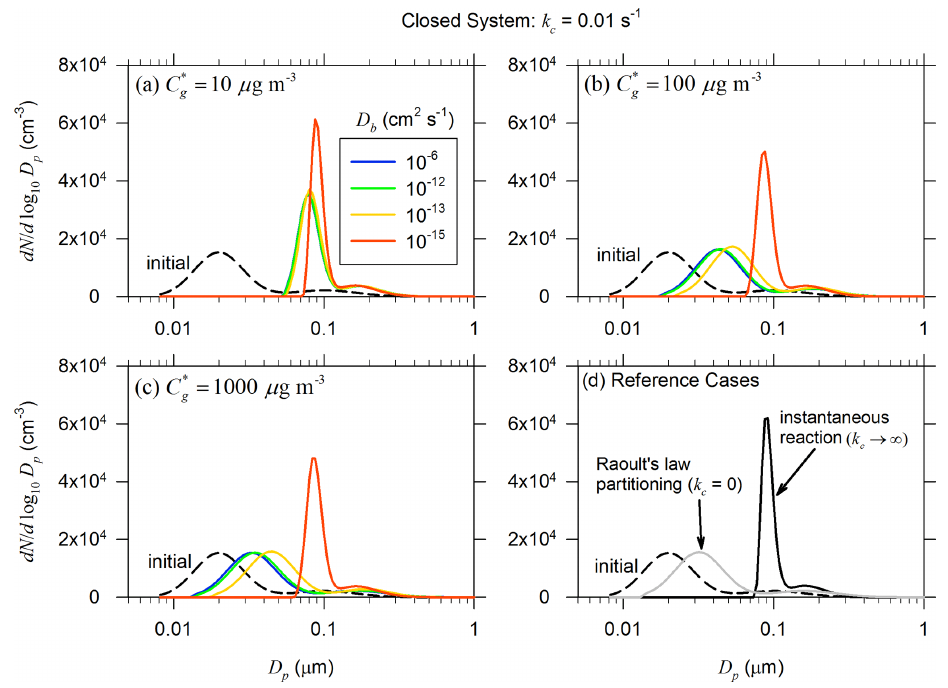
Figure 16. Initial (dashed line) and final (solid lines) aerosol number size distribution due to Raoult’s law gas-particle partitioning cou- pled with particle-phase reaction ( k c = 0.01s − 1 ) for bulk diffusivities ranging from 10 − 6 to 10 − 15 cm 2 s − 1 and three gas volatilities: (a) C ∗ g = 10µgm − 3 , (b) C ∗ g = 100µgm − 3 , and (c) C ∗ g = 1000µgm − 3 . Panel (d) shows the final size distributions for the two reference cases: instantaneous reaction (black line; k c → ∞ ) and Raoult’s law partitioning (gray line; k c = 0) for any D b and C ∗ g > 0. As illustrated in Fig. 15, the time required to reach the final state differs significantly for different cases, but the final SOA formed in each case is 6µgm − 3